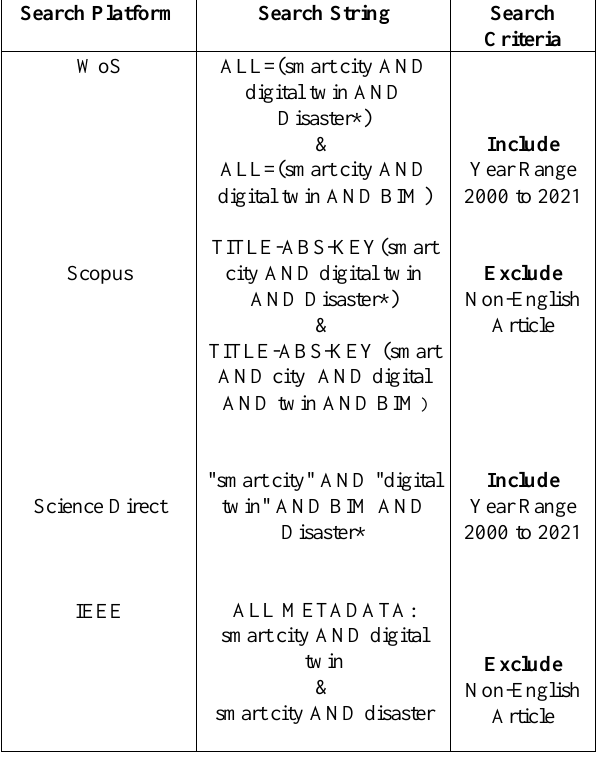
Table 1 . List of search queries, search platforms, search